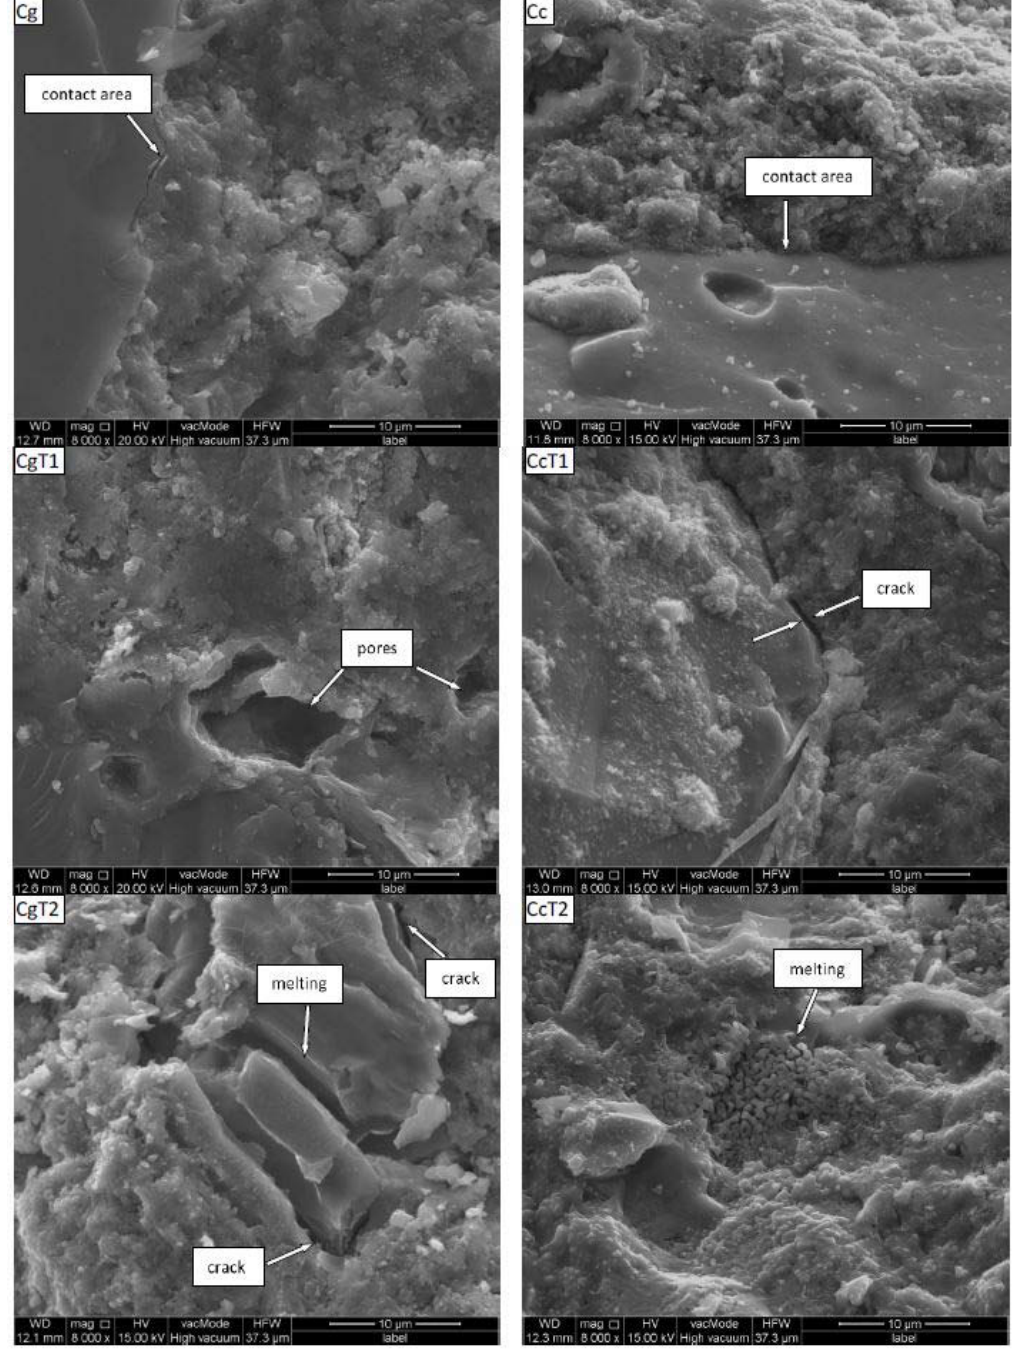
Figure 1. Representative SEM images of the surfaces of the broken concretes studied. Abbreviations: C–concrete, c–ceramics, g–granite and T–heated.